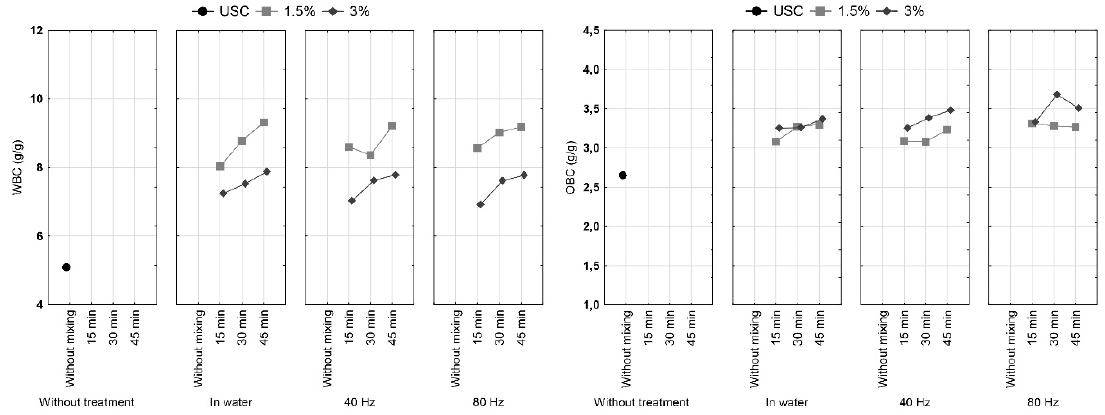
Figure 4. Oil and water binding capacity of cocoa shell before and after the HVED treatment.